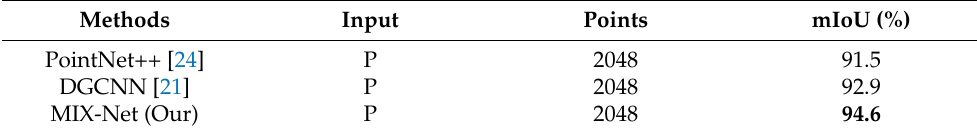
Table 2. Semantic segmentation results of MIX-Net on seedling point cloud datasets.